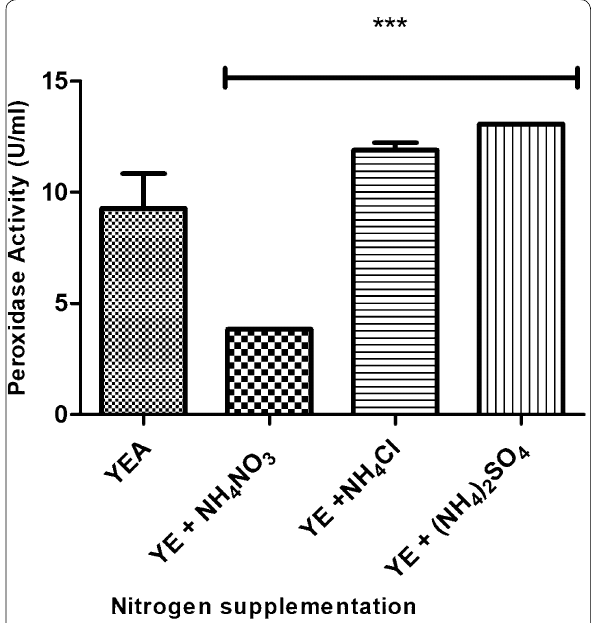
Fig. 5 Influence of inorganic nitrogen supplementation on peroxidase activity expression by BMAB-1. Each column signifies mean SD. ***Significantly different ( p < 0.05) from the control ( YEA ± yeast extract alone)